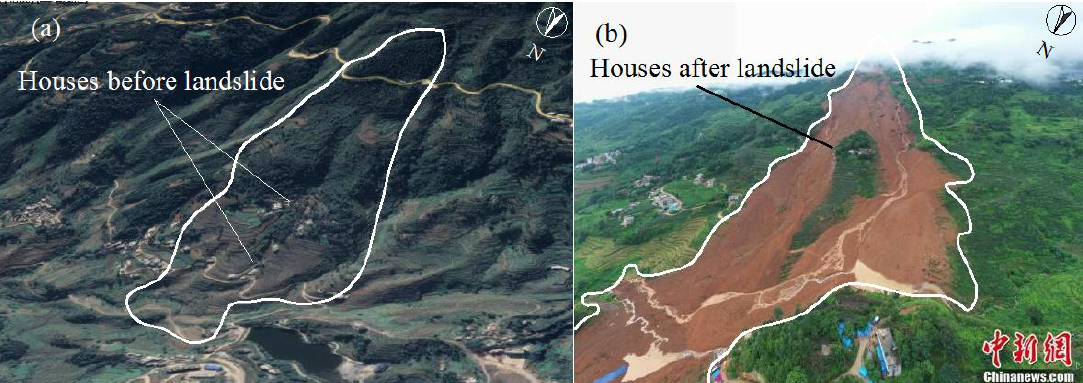
Figure 2. ( a ) Three-dimensional (3D) View from Google Earth before the landslide ( b ) Photo captured after the landslide (Source: http://gz.people.com.cn/n2/2019/0724/c194849-33174976-7.html).